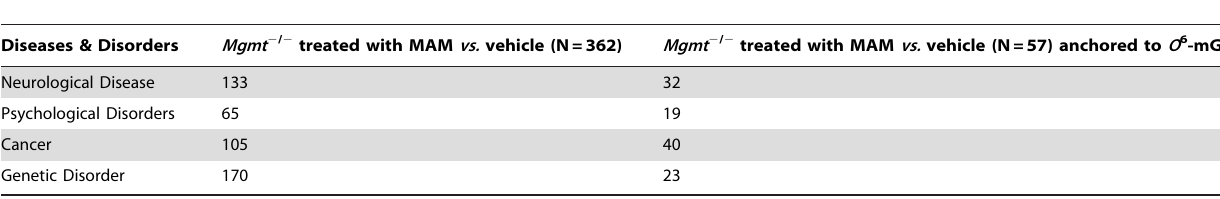
Table 1. Top MAM-sensitive biological functions in Mgmt 2 / 2 mouse brains.